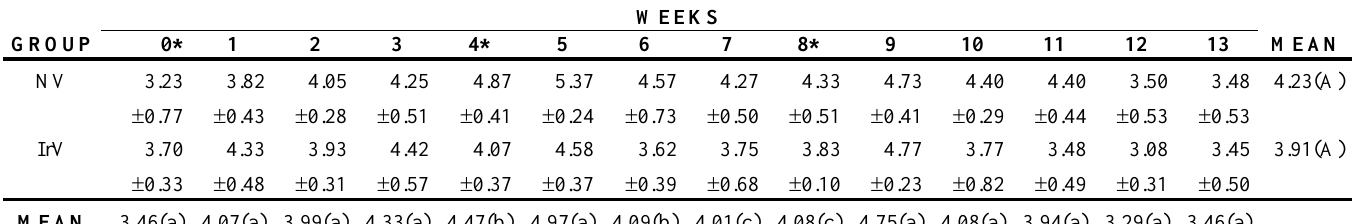
* Inoculations Difference between groups: F=1,12; p>0,10, GI=GII. Difference between times: F= 37,95; p<0,05. Interaction: F= 0.82; p>0.05 Different capital letters show significant statistical differences between groups. Different lowercase letters show significant statistical differences